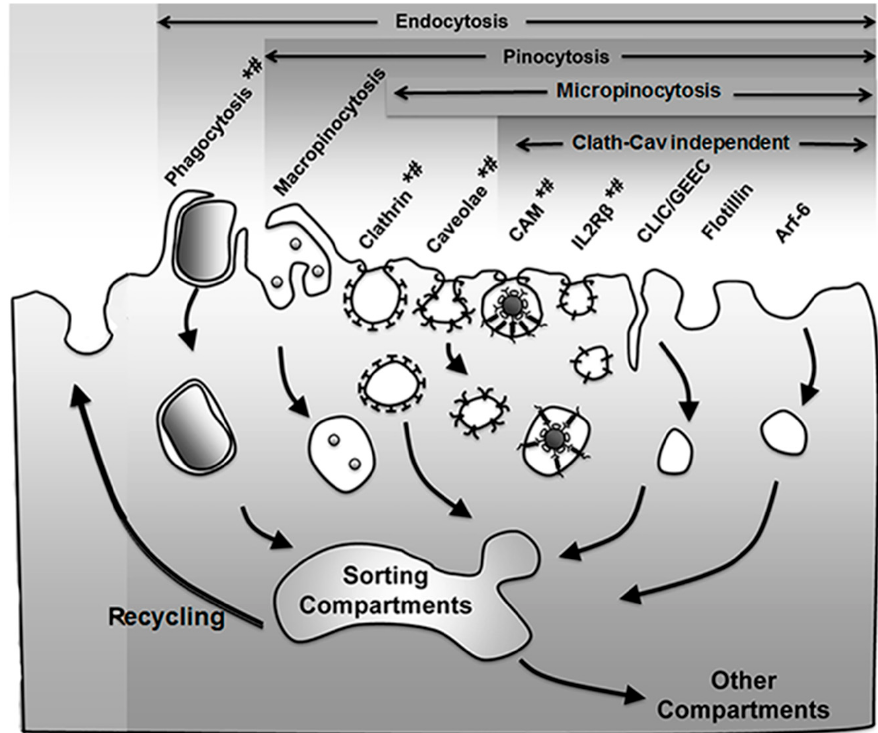
Figure 1. Endocytic pathways. Endocytosis via membranous vesicles encompasses several mechanisms where the plasmalemma internalizes objects (phagocytosis) and extracellular fluid (pinocytosis) in intracellular vesicles. Some vesicles concentrate receptors that mediate uptake of specific ligands via receptor-mediated endocytosis (marked by *), while others (e.g., macropinocytosis) largely internalize fluid and solutes by non-specific means. Pinocytosis is subdivided in macro- and micropinocytosis depending on the size of the vesicles that form and the latter can be mediated by classical (clathrin- and caveolae-mediated pathways) or non-classical (clathrin and caveolae independent) routes, all of which can be classified as per their dynamin dependence (marked by # ). Apart from the trafficking destinations shown, some markers (e.g., platelet – endothelial cell adhesion molecule 1 (PECAM-1) and intercellular adhesion molecule 1 (ICAM-1) associated with the cell adhesion molecule (CAM)-mediated pathway) may shuttle back and forth between the cell surface and a subplasmalemma vesicular compartment whose membrane is continuous with the plasmalemma. Adapted and reproduced with permission from Figure 12.2 in [26]. Copyright 2016 Pan Stanford.